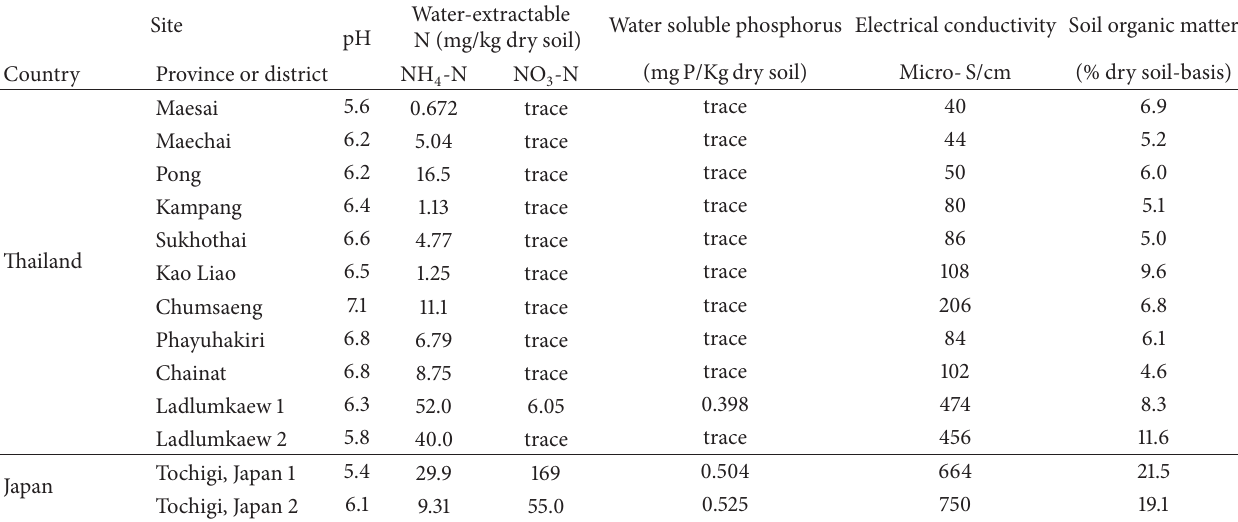
Figure 5: Paddy soil surface covered by Azolla. A reddish species in rapid propagation (a), a greenish species drying on the soil surface (b), and a greenish species decomposing on the dry soil surface (c). Table 3: Properties of soils of the Thai paddy fields and the Tochigi fields in